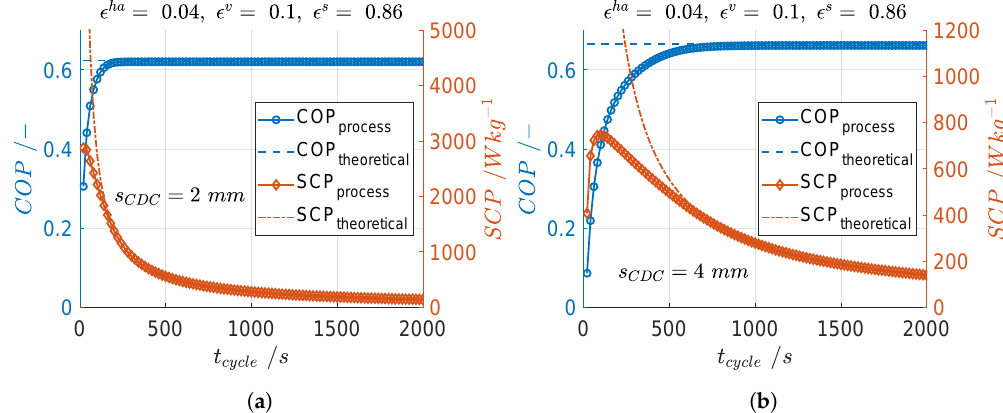
Figure 9. Coefficient of performance and specific cooling power for a wide variation of cycle time and one material with different layer thickness. ( a ) Optimization of cycle time for a constant CDC-plate layer thickness of 2 mm. ( b ) Optimization of cycle time for a constant CDC-plate layer thickness of 4